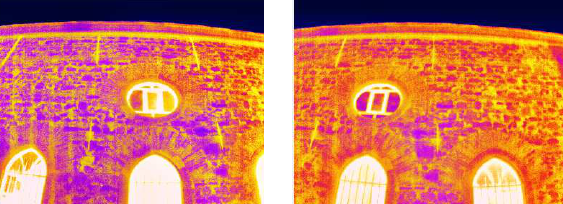
Figure 5a. Enhanced left image 5b. Enhanced right